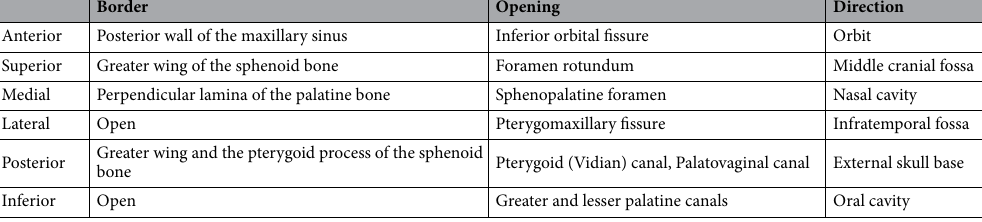
Table 1. Main borders and openings of the pterygopalatine fossa 1 .